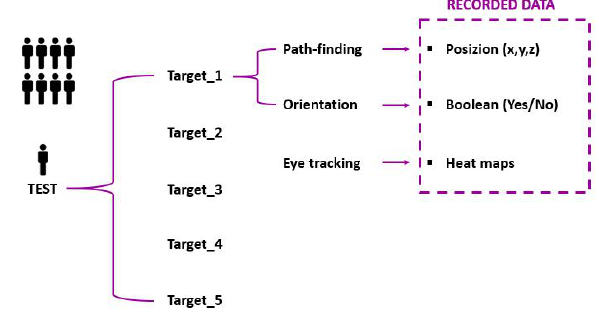
Figure 5: Overview of the developed